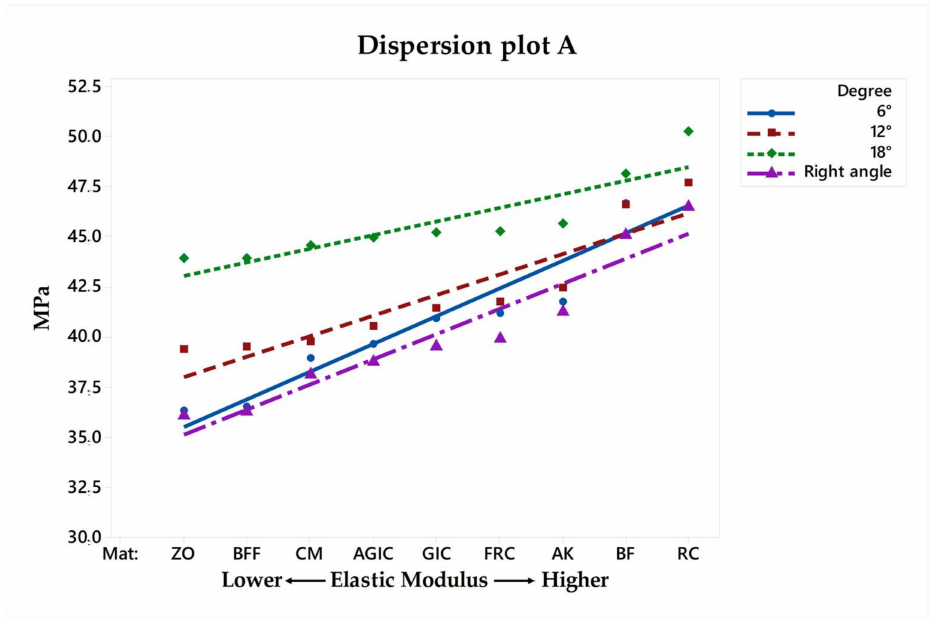
Figure 4. Dispersion plot according to the filling material elastic moduli and stress peaks recorded in the endocrown restoration.